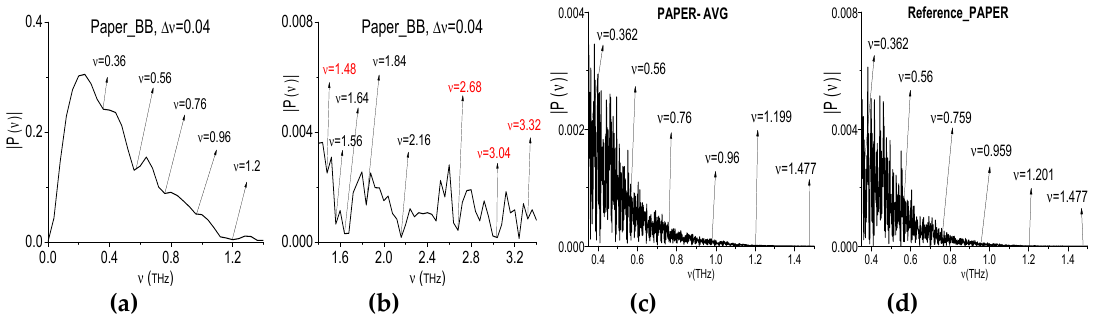
Figure 18. The Paper_BB spectrum in the frequency ranges ν = [0, 1.4] THz ( a ), [1.4, 3.4] THz ( b ). Figure 18 . The Paper_BB spectrum in the frequency ranges ν = [0, 1.4] THz (a) , [1.4, 3.4] THz (b). The The Paper_AVG ( c ) and reference spectrum ( d ) in the frequency range ν = [0.35, 1.5] THz. Paper_AVG (c) and reference spectrum (d) in the frequency range ν = [0.35, 1.5] THz .